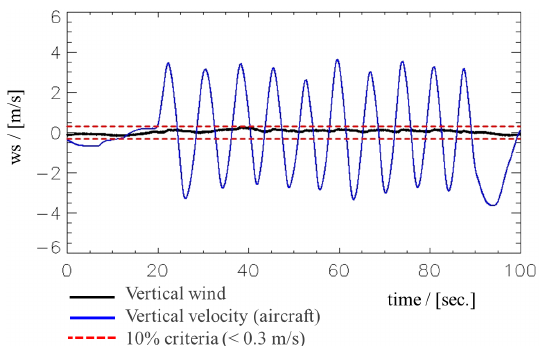
Figure 10. Results of the vertical wind calculation during harmonic pitch oscillation. The sinusoidal signal can clearly be seen in the vertical velocity of the aircraft, while it vanishes completely in the vertical wind component. The criterion for an accurate calibration is that the residual error of the vertical wind is less than 10% of the vertical velocity (e.g. 0.3ms − 1 ).